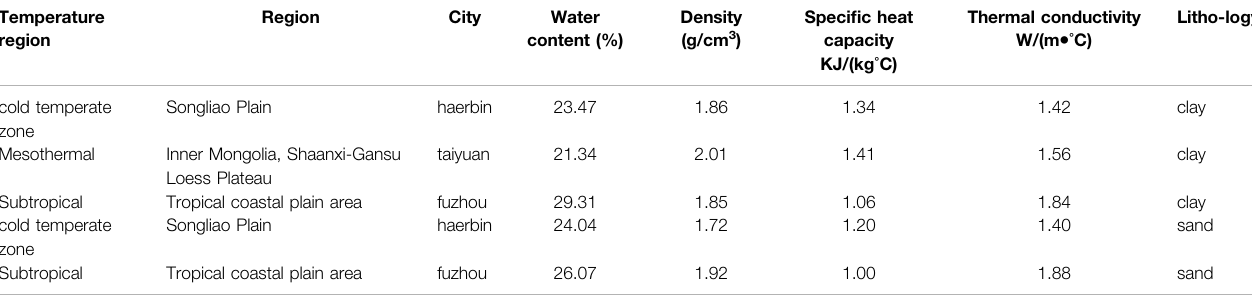
TABLE 5 | Temperature region analysis results for thermophysical